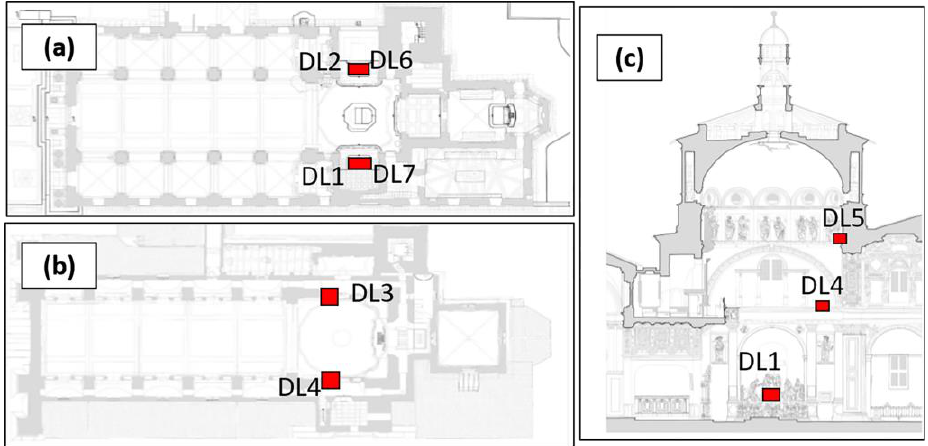
Figure 10. The floor plans and sections of the sanctuary showing the placement of the dataloggers: